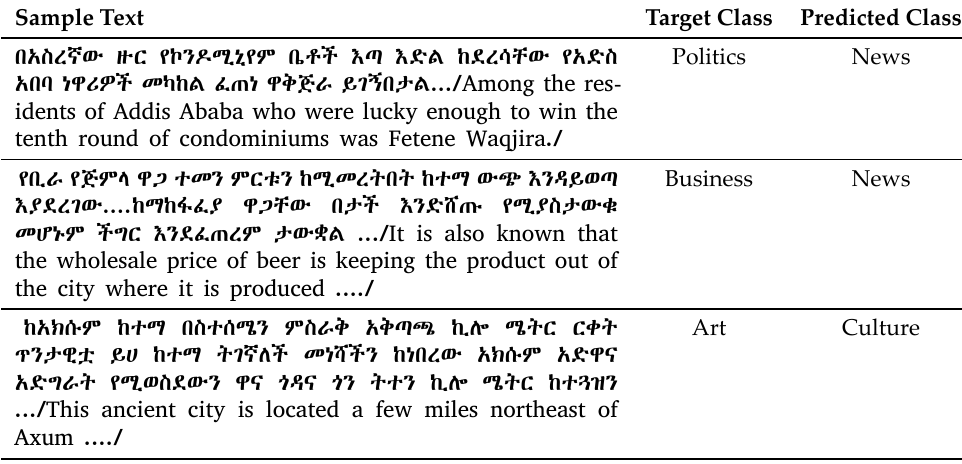
Table 7. Sample of Incorrectly Predicted Texts by SVM Topic